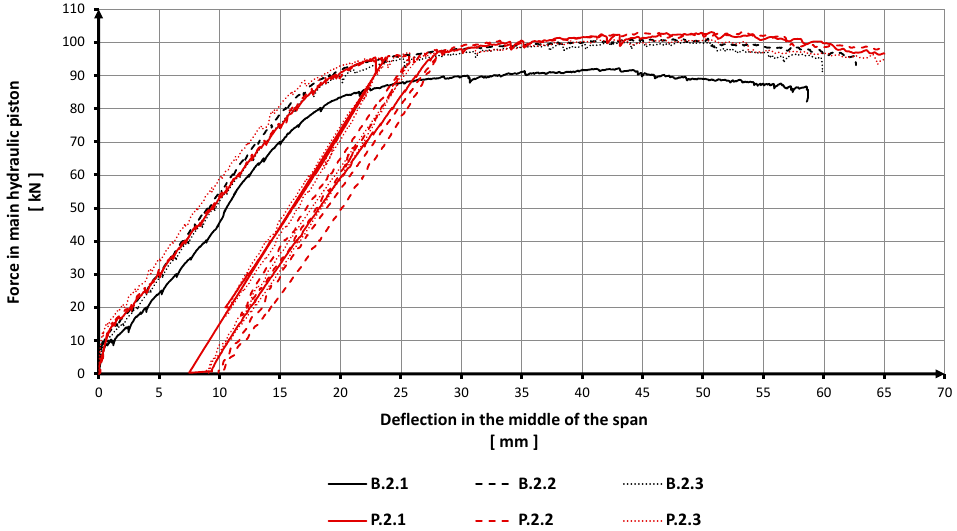
Figure 8. Force (exerted by the hydraulic piston) vs. beam deflection.